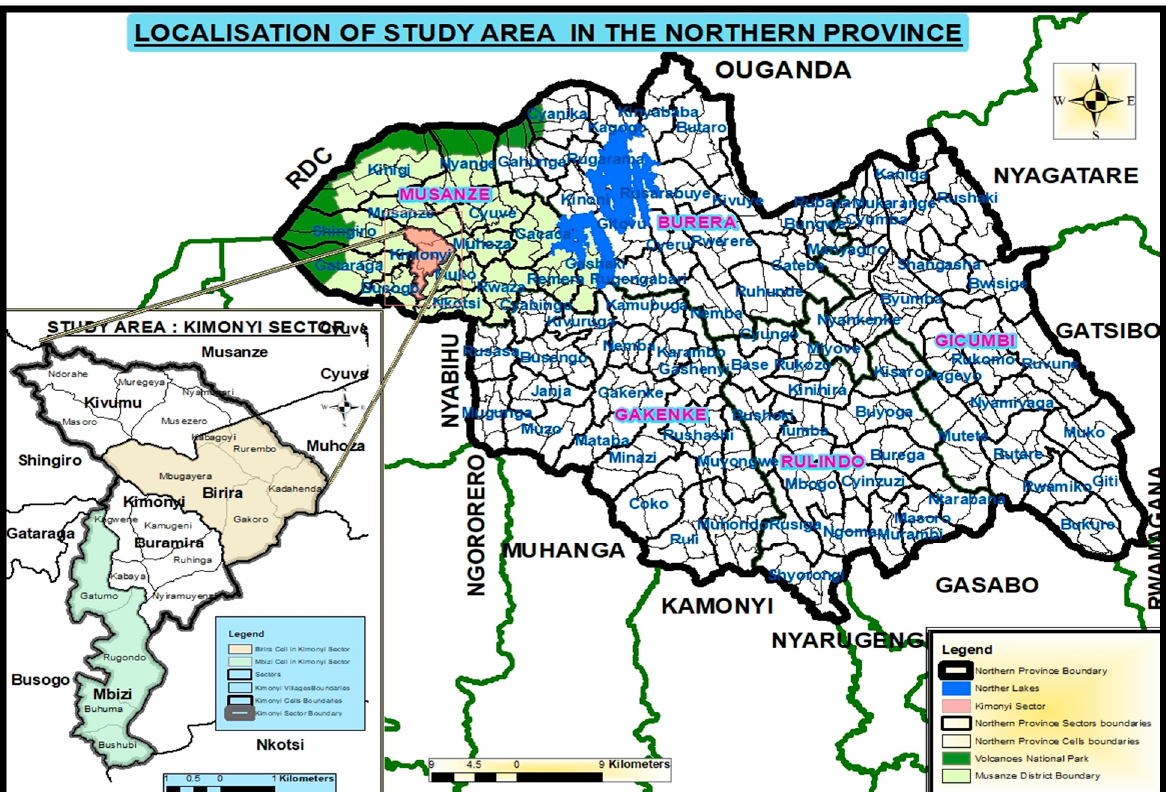
Figure 2. Study area of Kimonyi Sector, Musanze District, in the Northern Province. Source: One Stop Centre, Musanze District.